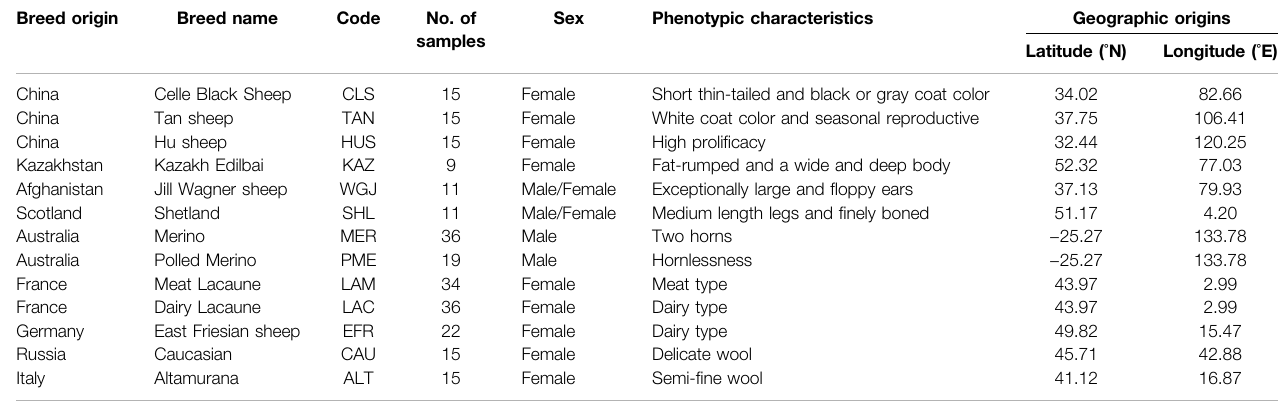
TABLE 1 | Summary information of 13 breeds of domestic sheep.